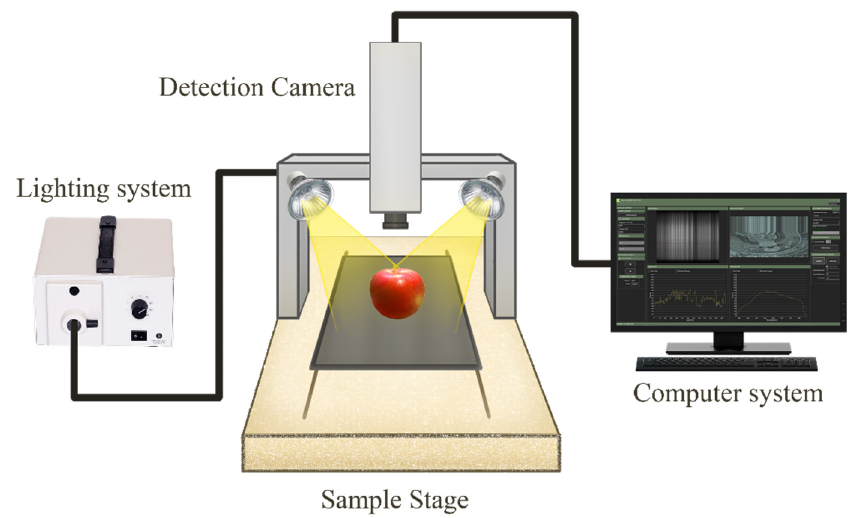
Figure 1. Schematic of the hyperspectral imaging system.